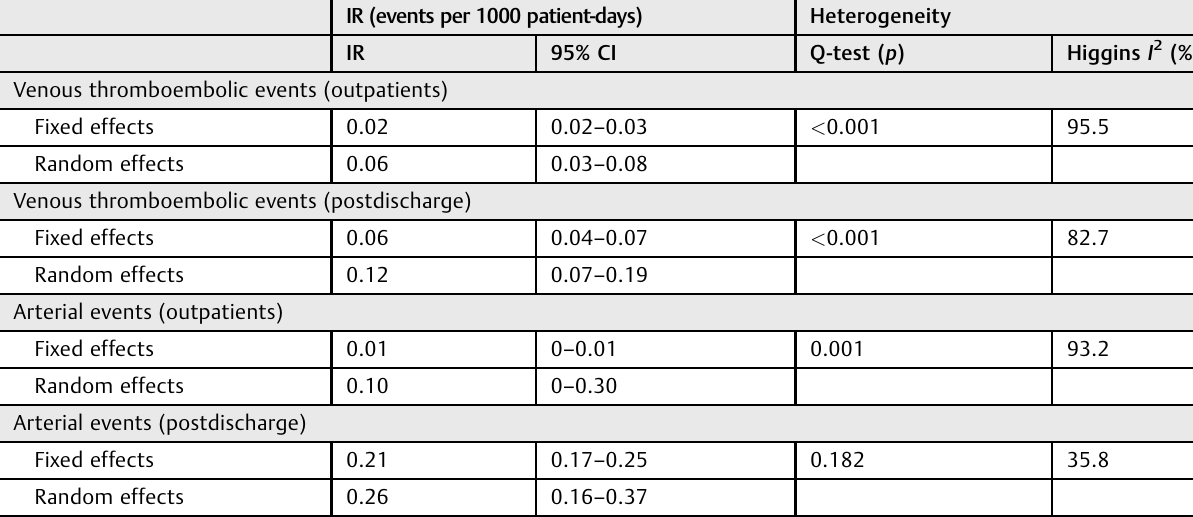
Table 3 Pooled estimates for incidence rate of venous and arterial thrombotic events in ambulatory and postdischarge